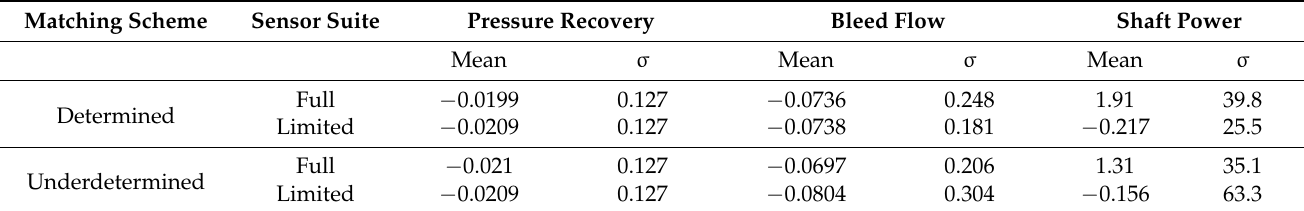
Table 7. Estimated installation effect deviation, without measurement noise.